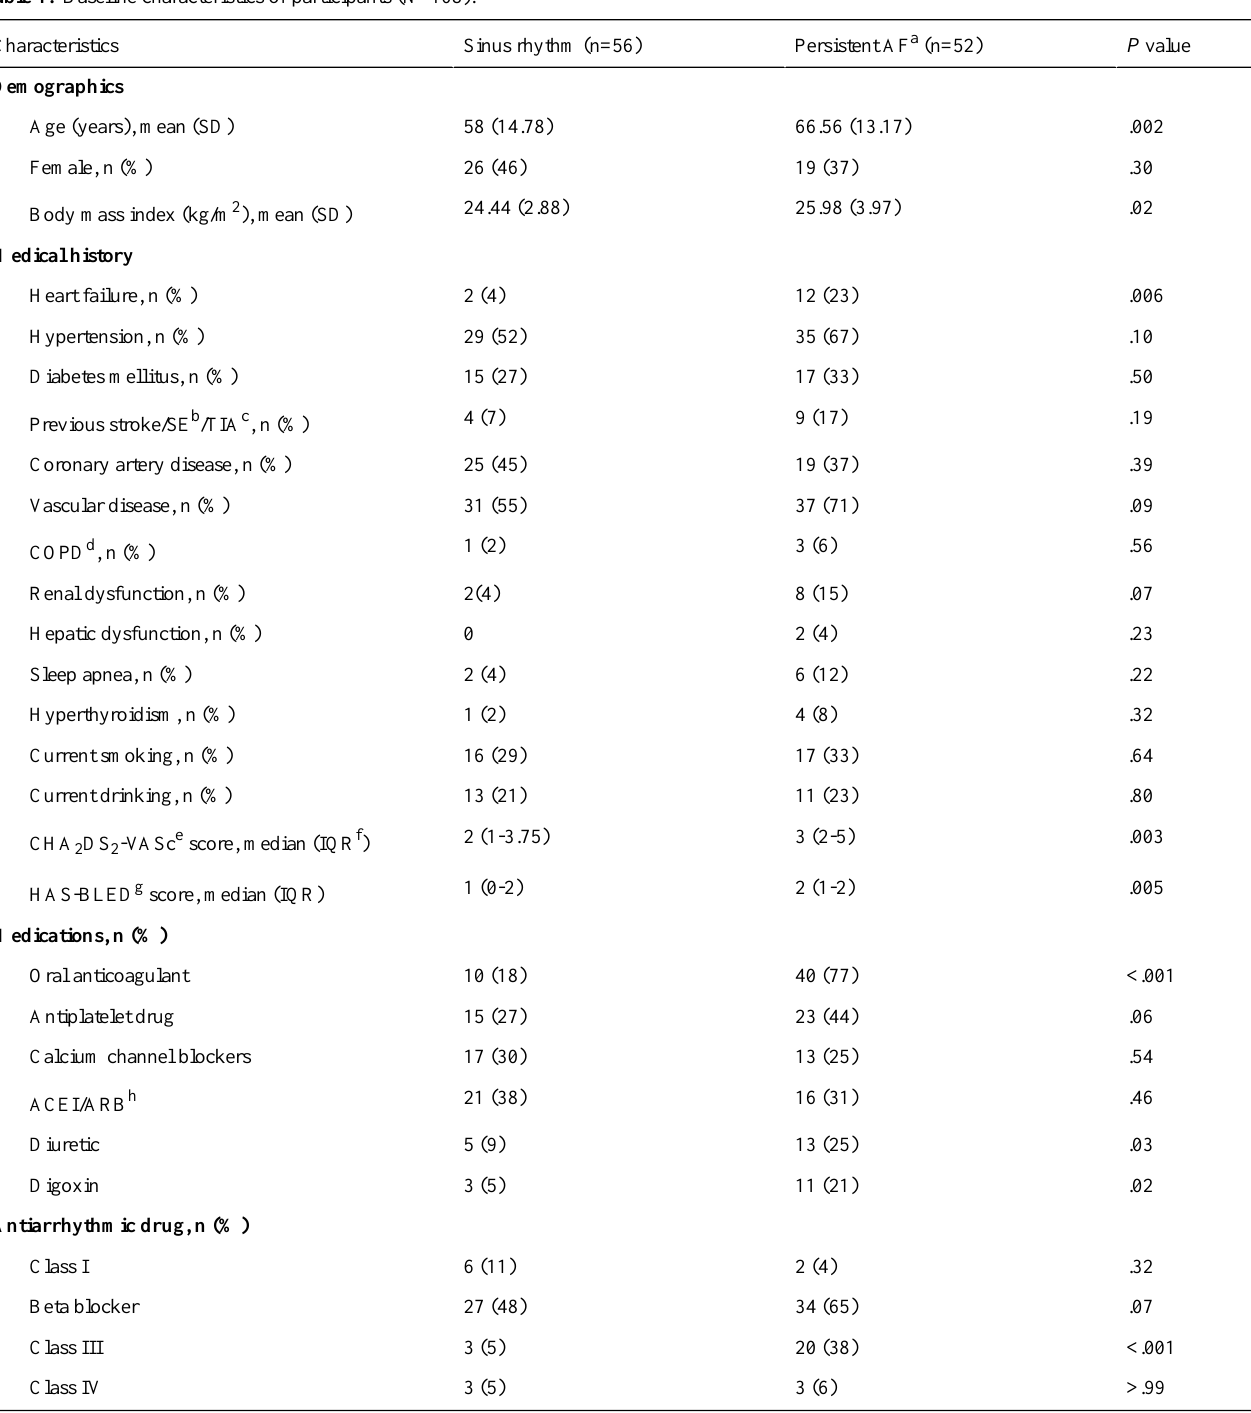
Table 1. Baseline characteristics of participants